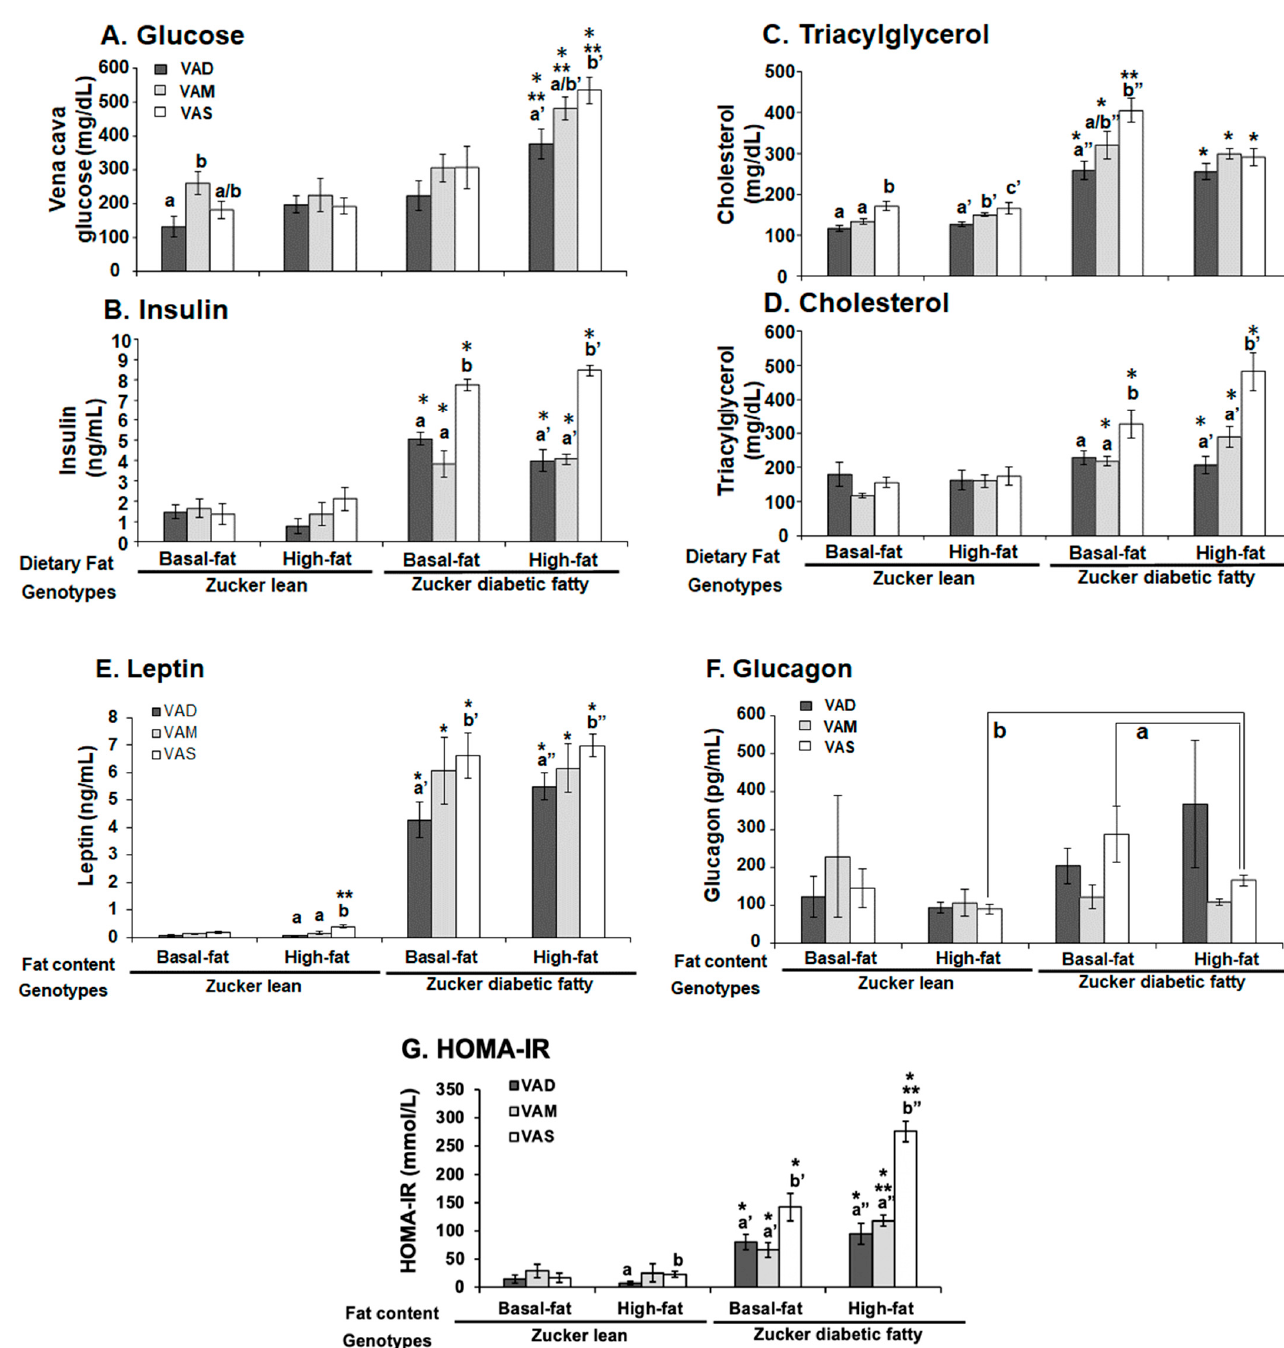
Figure 7. The venous blood levels of glucose (A), triacylglycerol (B), insulin (C), cholesterol (D), leptin (E), and glucagon (F), and HOMA ‐ IR (G) in ZL and ZDF rats fed a VAD, VAM or VAS diet with BF or HF content. For ( A – E , G ), a < b, a’ < b’, a” < b”, and a’’’ < b’’’ for comparing the groups in the same fat content and genotype using one ‐ way ANOVA; * for comparing ZL and ZDF groups with the same diet; ** for comparing BF with HF groups within the same genotype; all p < 0.05. For F, a for comparing the BF and HF conditions with the same rat genotype and VA status; b for comparing the ZL and ZDF rats in the same VA status and dietary fat content. The venous blood TAG level of ZL rats fed the VAS ‐ BF diet was higher than that of the rats fed the VAM ‐ BF or VAD ‐ BF diet, as shown in Figure 7B. The TAG level of ZL rats fed the VAD ‐ HF diet was lower than that of the rats fed the VAM diet, which was lower than that of the rats fed the VAS ‐ HF diet. The TAG level of ZDF rats fed the VAD ‐ BF diet was lower than that of the rats fed the VAS ‐ BF diet, whereas those fed the VAM ‐ BF was not different from these two. The TAG levels of ZDF rats fed the VAD ‐ HF, VAM ‐ HF and VAS ‐ HF were not different, showing the impact of the HF diet. The TAG level of ZDF, but not ZL, rats was higher than that of ZL rats fed the same diet. Interestingly, the TAG levels of ZDF rats fed the VAS ‐ BF diet was higher than that of rats fed the VAS ‐ BF diet. Figure 7C shows that the plasma insulin levels of ZL rats were significantly lower than that in ZDF rats fed the same diet. The venous blood insulin levels of ZL rats fed the BF and HF diets were not different among the three groups with different VA statuses and fat contents. The plasma insulin levels of ZDF rats fed the VAD/VAM ‐ BF, or VAD/VAM ‐ HF diets were significantly lower than those of ZDF rats fed VAS ‐ BF or VAS ‐ HF diets, respectively. These results indicate that the dietary VA may directly affects plasma insulin levels in ZDF rats, regardless the dietary fat contents. Figure 7D shows that the cholesterol levels of ZDF rats fed the indicated diets (except the VAD ‐ HF diet) were higher than ZL rats fed the same diet. The plasma cholesterol levels in ZL rats were not affected by the VA statuses and dietary fat contents. The plasma cholesterol levels of ZDF rats fed the VAS ‐ BF and VAS ‐ HF diets were higher than the ZDF rats fed the VAD ‐ BF or VAM ‐ BF and VAD ‐ HF or VAM ‐ HF diets, respectively. Figure 7E shows that the leptin levels of ZL rats fed the BF diet with different VA statues were similar. The leptin levels of ZL rats fed the VAD ‐ HF and VAM ‐ HF diets were lower than those of the rats fed the VAS ‐ HF diet. The ZDF rats fed the VAD ‐ BF and VAD ‐ HF diets had lower leptin levels than that fed the VAS ‐ BF and VAS ‐ HF diets, respectively. On the other hand, the leptin levels of ZDF rats fed the VAM ‐ BF and VAM ‐ HF diets were not different. The leptin levels of ZL rats fed the indicated diets were significantly lower than those of ZDF rats fed the same diets. There is a significant increase in plasma leptin levels in ZL rats fed the VAS ‐ HF diet compared with those fed the VAS ‐ BF diet. Figure 7F shows that the glucagon levels of ZDF rats fed the VAS ‐ HF diet were higher than those of ZL rats fed the VAS ‐ HF diet and lower than those of ZDF rats fed the VAS ‐ BF diet. The HOMA ‐ IR values were calculated based on the plasma glucose and insulin lev ‐ els, as shown in Figure 7G. The ZL rats fed the BF diets with different VA statuses had similar HOMA ‐ IR values, and the ZL rats fed the VAS ‐ HF diet have higher HOMA ‐ IR values than ZL rats fed the VAD ‐ BF diet. The HOMA ‐ IR values of ZDF rats fed VAS ‐ BF or VAS ‐ HF diets were, respectively, higher than those of ZDF rats fed the VAD ‐ BF and VAM ‐ BF, or VAD ‐ HF and VAM ‐ HF diets, respectively. The HOMA values of ZDF rats fed the VAM ‐ HF or VAS ‐ HF diet were, respectively, higher than those of ZDF rats fed the